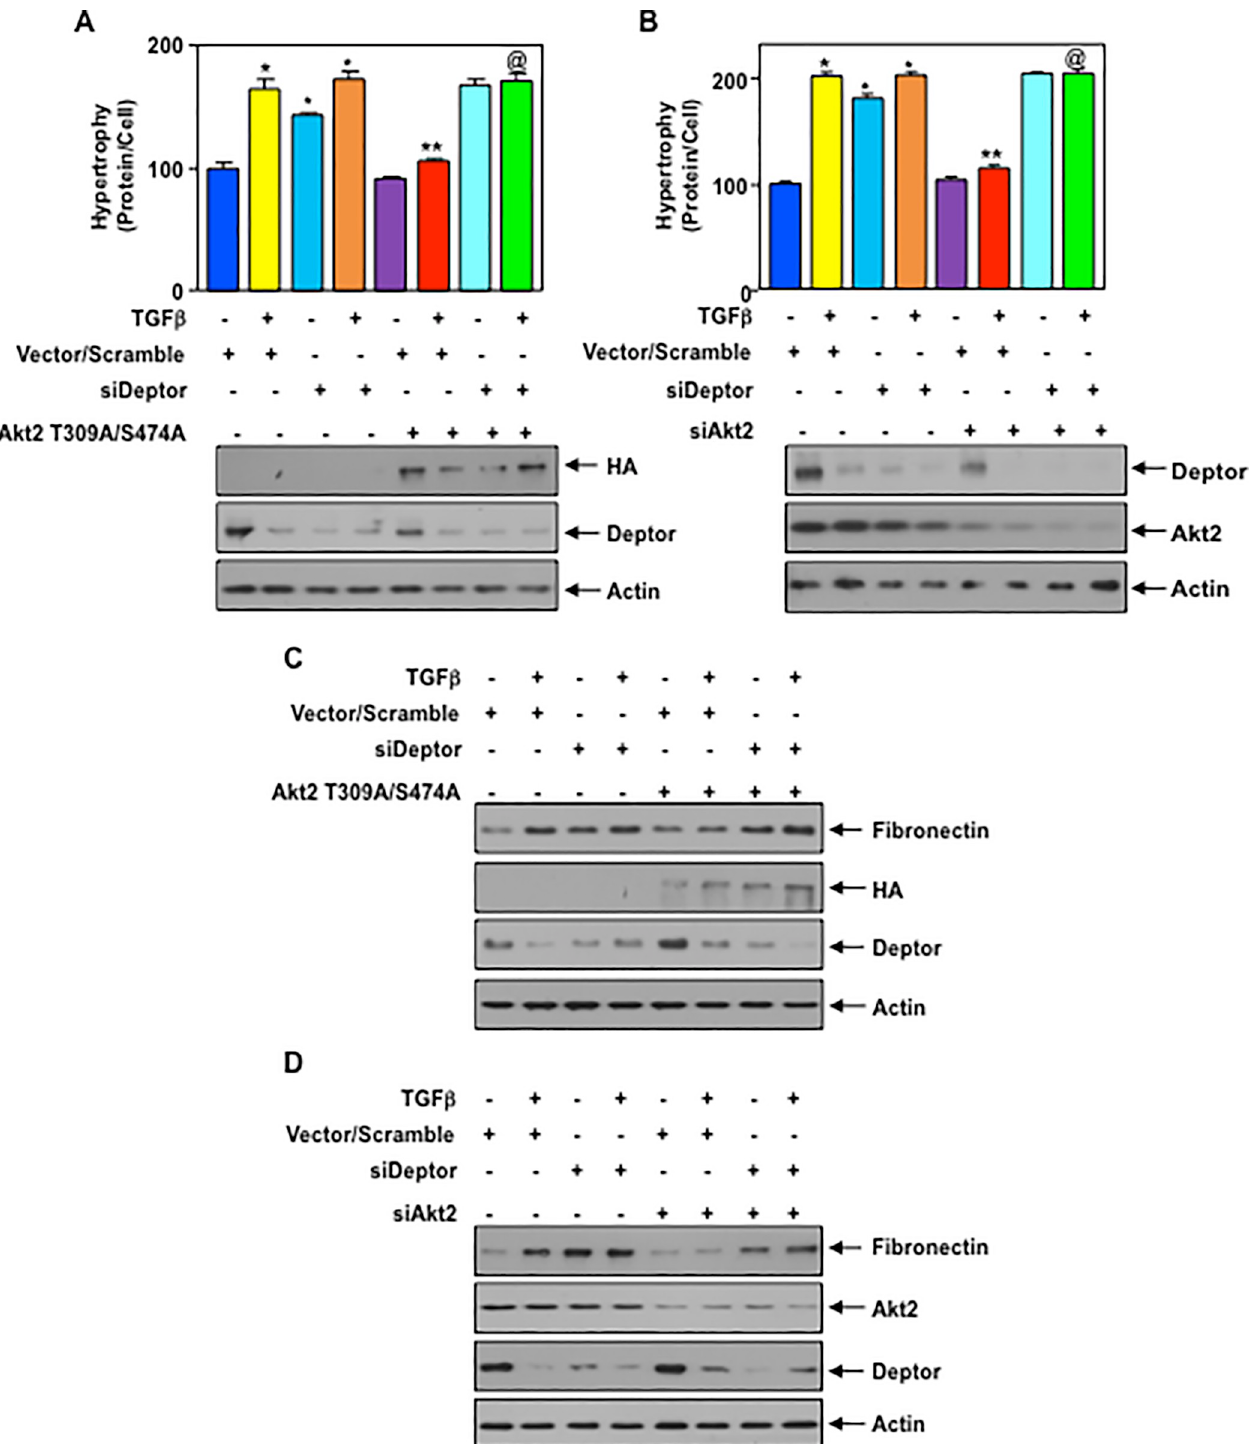
Fig 9. Phospho-deficient mutant of Akt2 and siRNA against Akt2 block TGF β induced podocyte hypertrophy and expression of fibronectin by deptor. (A—D) Podocytes were transfected with Akt2 T309A/S474A mutant plasmid (panels A and C) or siRNA against Akt2 (panels B and D) along with siRNA for deptor. The transfected cells were starved and incubated with TGF β In panels A and B, the hypertrophy of the cells was determined as described in the Materials and Methods. Mean ± SE of triplicate measurements is shown. � , vs control; �� , vs TGF β @, vs TGF β plus Akt2T309A/S474A. p < 0.001. Bottom panels show the expression of Akt2 mutant and deptor along with actin. (C and D) The cell lysates were immunoblotted with indicated antibodies. Representative of 3 independent experiments is shown. The quantification of fibronectin expression in Fig 9C and 9D is shown in the S12 Fig. https://doi.org/10.1371/journal.pone.0207285.g009 PLOS ONE | https://doi.org/10.1371/journal.pone.0207285 November16, 2018 14 /